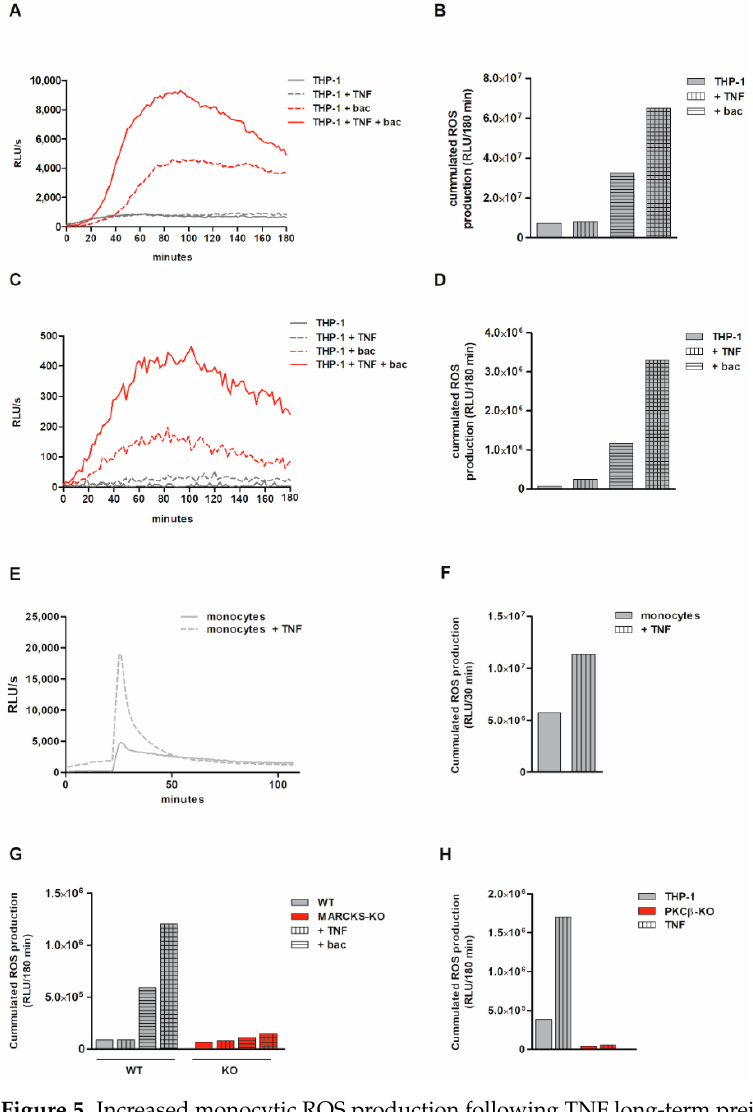
Figure 5. Increased monocytic ROS production following TNF long-term preincubation is dependent on MARCKS and PKC β . ( A , B ) Kinetics ( A ) and the respective cumulated production (i.e., the AUC) within 180 min ( B ) of opsonized bacteria-induced ( ≥ 5 bacteria/cell) total ROS generated by 5 d calcitriol-differentiated THP-1 cells following preincubation with 80 ng/mL TNF for 48 h (i.e., added at day 3). Total ROS production was assessed via luminol-amplified chemiluminescence (in RLU/s) (representative experiment, n = 3). ( C , D ) Kinetics ( C ) and the respective cumulated production within 180 min ( D ) of opsonized bacteria-induced intracellular ROS generated by differentiated THP-1 cells following TNF preincubation as described in ( A ) (representative experiment, n = 3). ( E , F ) Kinetics ( E ) and the respective cumulated production within 30 min ( F ) of PMA-induced (100 nM) total ROS generated by primary human monocytes following TNF preincubation (80 ng/mL TNF for 48 h; representative experiment, n = 4). ( G ) Cumulated intracellular ROS production in MARCKS WT and KO clones (incubated as in ( A )) within 180 min following stimulation with bacteria (representative experiment, n = 3). ( H ) Cumulated intracellular ROS production in THP-1 and PKC β KO cells (incubated as in ( A )) within 180 min following stimulation with bacteria (representative experiment, n =